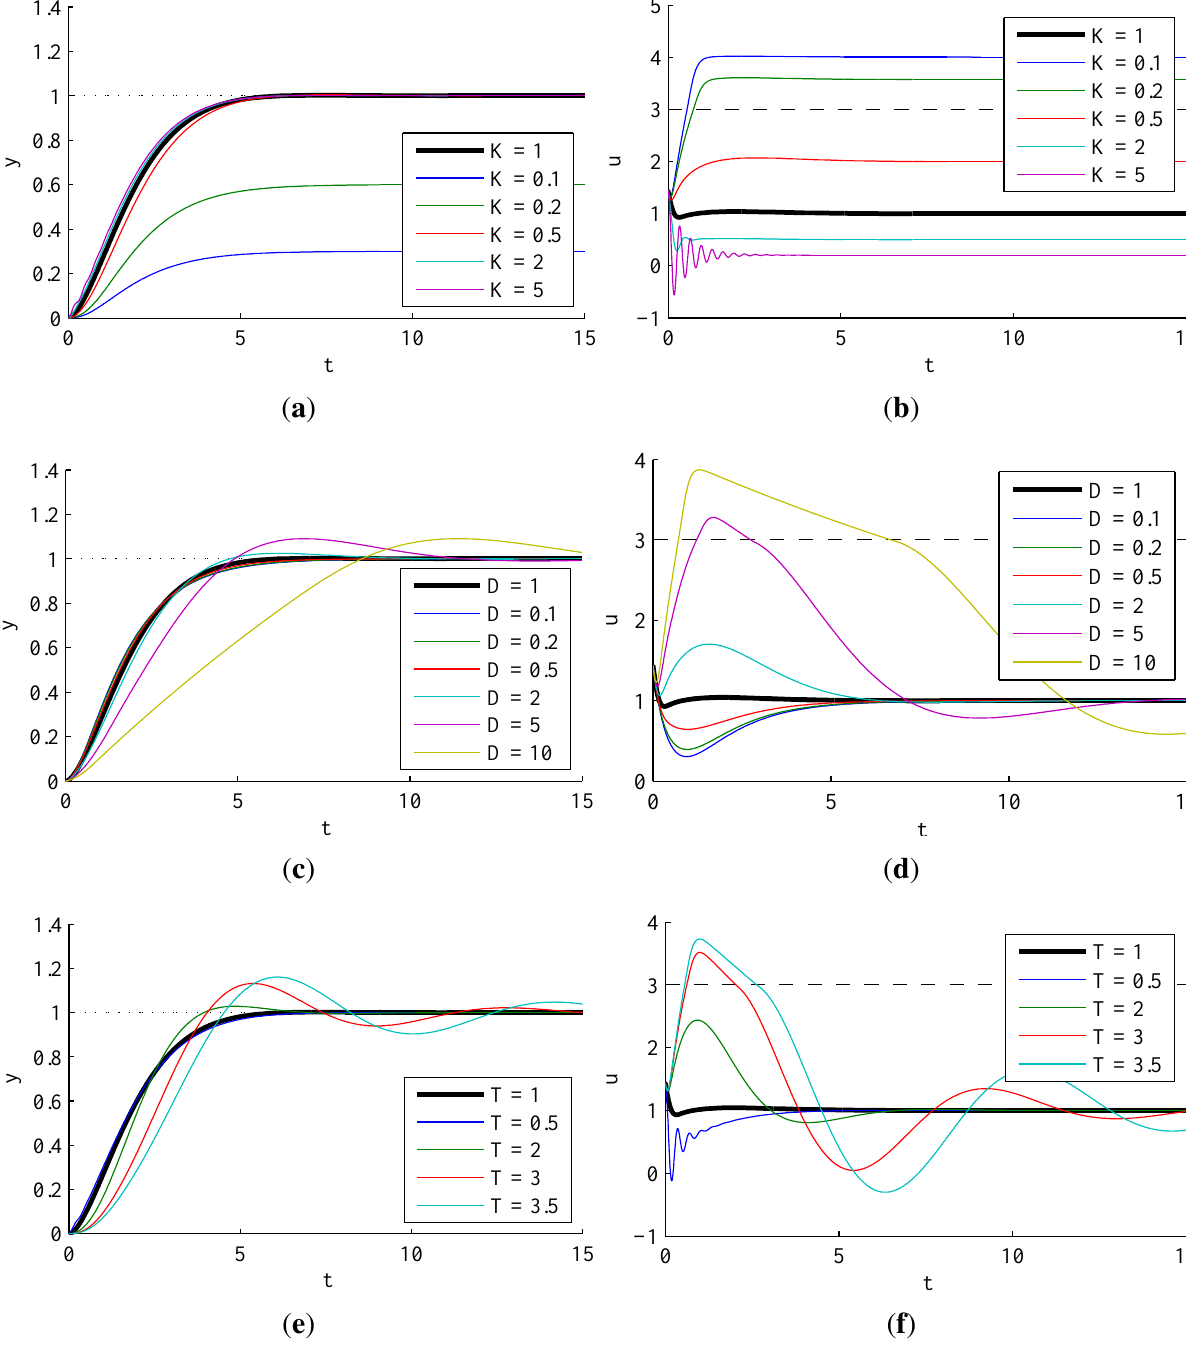
u 3, on a fixed second-order lim | ≤ |